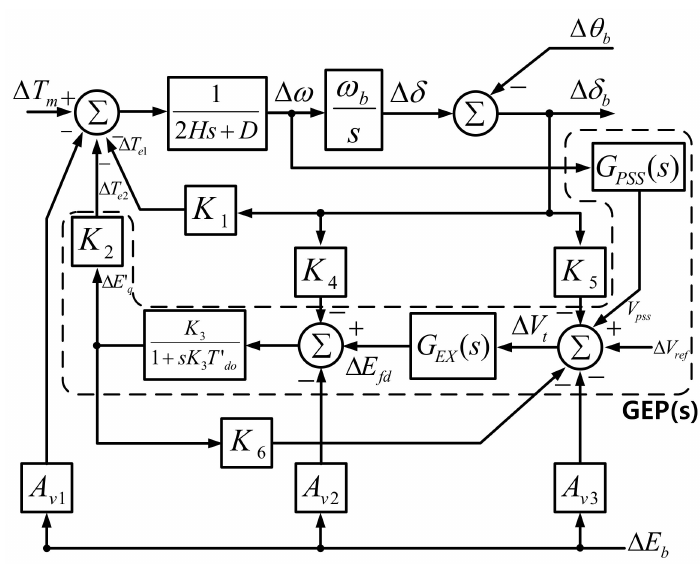
Figure 6. Linearized model of a single machine connected to a non-stiff